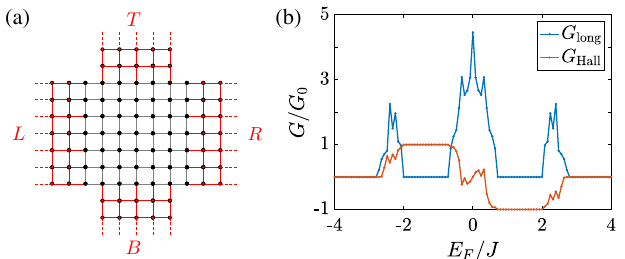
FIG. 3. (a) Example of a four-terminal setup with a square lattice geometry of N x ¼ N y ¼ 7 sites along the x and y directions, respectively. The system is represented by the black dots, while the red dots identify the sites of the left ( L ), right ( R ), top ( T ), and bottom ( B ) reservoirs. (b) Longitudinal ( G G L;R ) and transverse Hall conductance ( the Harper-Hofstadter model with magnetic flux φ ¼ 2 π = 3 for an input bias applied to the left reservoir; the system size is N x ¼ N y ¼ 30